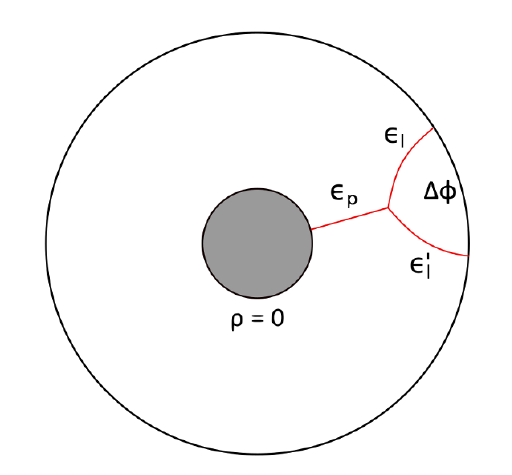
Figure 6 . The con(cid:12)guration of geodesics in the background of the BTZ black hole at the constant time slice, which is dual to the semiclassical 4-point heavy-light conformal block on the sphere. The smaller circle is the event